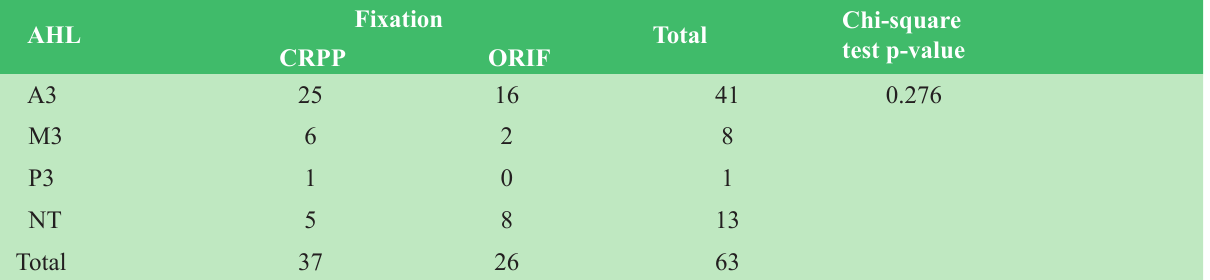
Table 6: Anterior Humeral Line vs. Type of